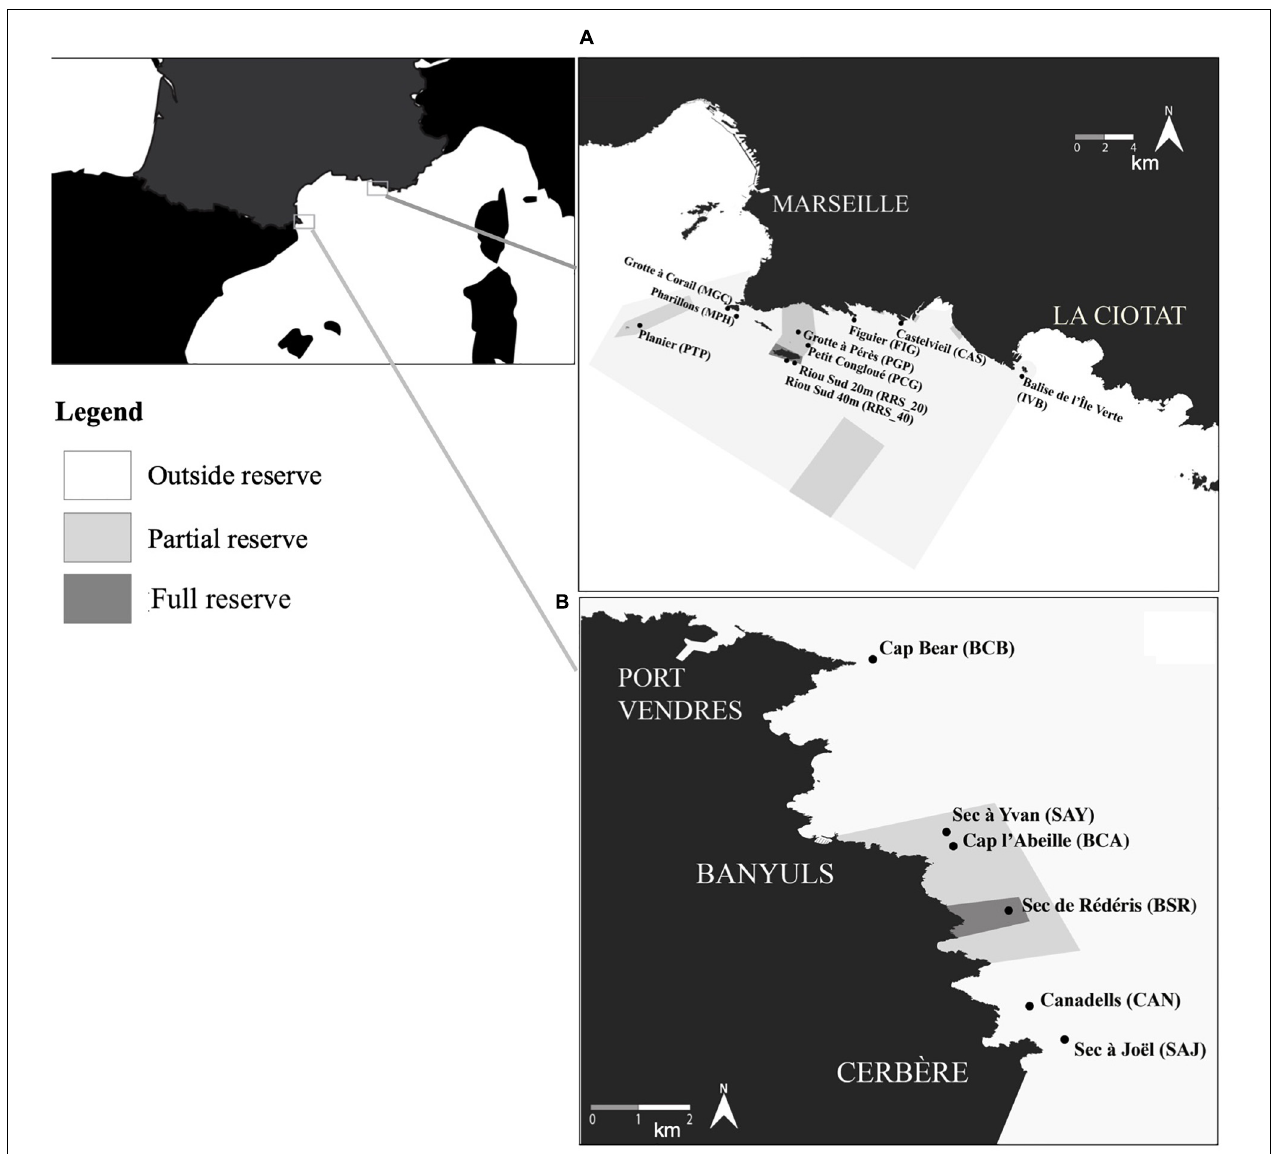
FIGURE 1 | Study areas with Calanques national park (A) and Cerbère-Banyuls reserve (B) .